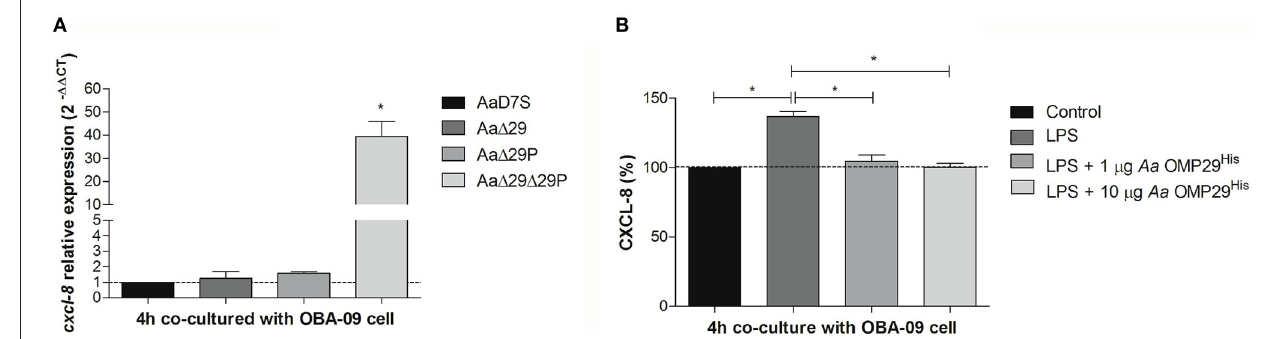
FIGURE 2 | Chemokine CXCL-8 expression. (A) cxcl-8 relative transcription. Aa wildtype strain (AaD7S) and its mutant strains (Aa 1 29, Aa D7S-1 omp29 mutant strain; Aa 1 29P, Aa D7S-1 omp29 par mutant strain; Aa 1 29 1 29P, Aa D7S-1 omp29 and omp29 par mutant strain) were grown in mTSB until mid-exponential phase and then co-cultured with confluent monolayers of OBA-09 cells for 4h in complete KSF medium. After the RNA extraction and cDNA synthesis, qRT-PCR was performed and relative mRNA levels of cxcl-8 were evaluated using gapdh as reference. OBA-09 cell was co-cultured with AaD7S as a control (dotted line). *One-way ANOVA followed by Dunnett’s post-test (significant, p < 0.05). (B) CXCL-8 production. OBA-09 cells were grown in KSF medium and challenged with E. coli serotype O111:B4 LPS followed by treatment with 1 µ g/ml and 10 µ g/ml Aa OMP29 His for 4h. CXCL-8 levels in cell supernatants were evaluated by ELISA, and data were reported as the percentages of CXCL levels in relation to non-inoculated cells (control) (dotted line). LPS, lipopolysaccharide; Aa OMP29 His , OMP29 recombinant protein of Aa HK1651. *One-way ANOVA followed by Tukey’s post-test (significant, p <